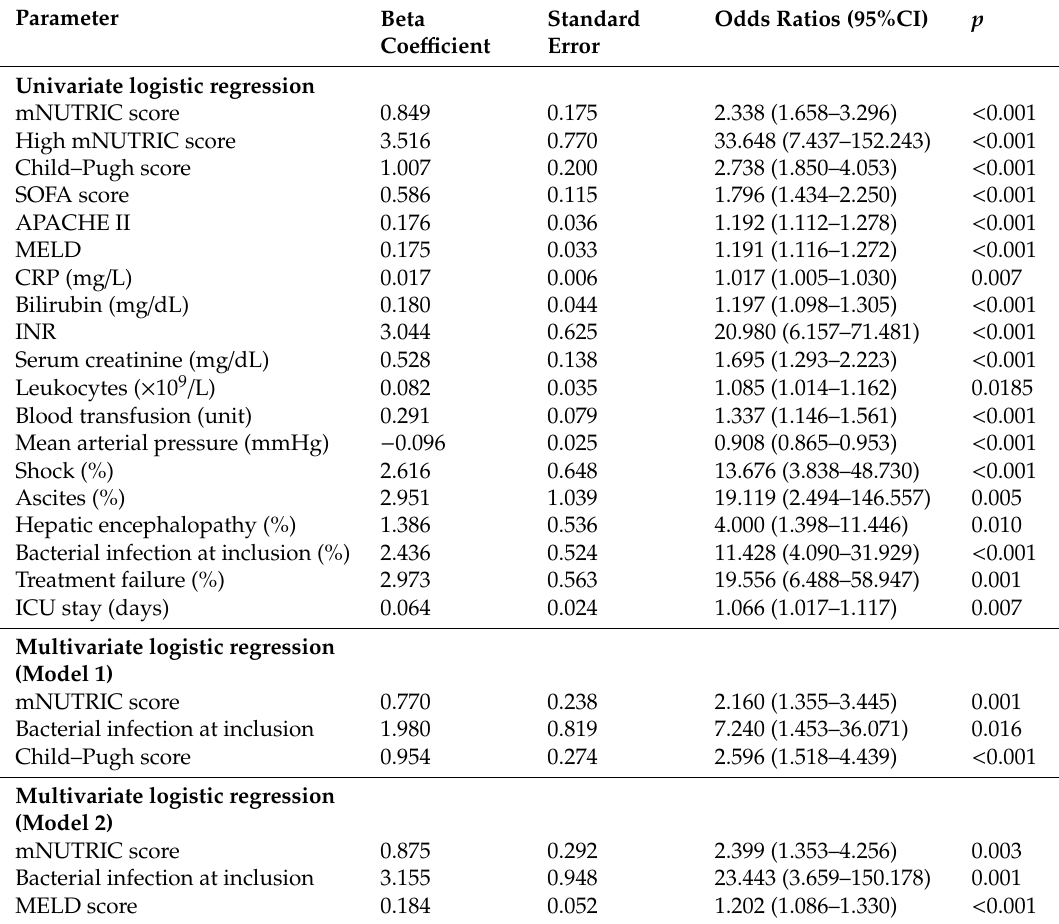
Table 2. Multivariate analysis to predict 6-week